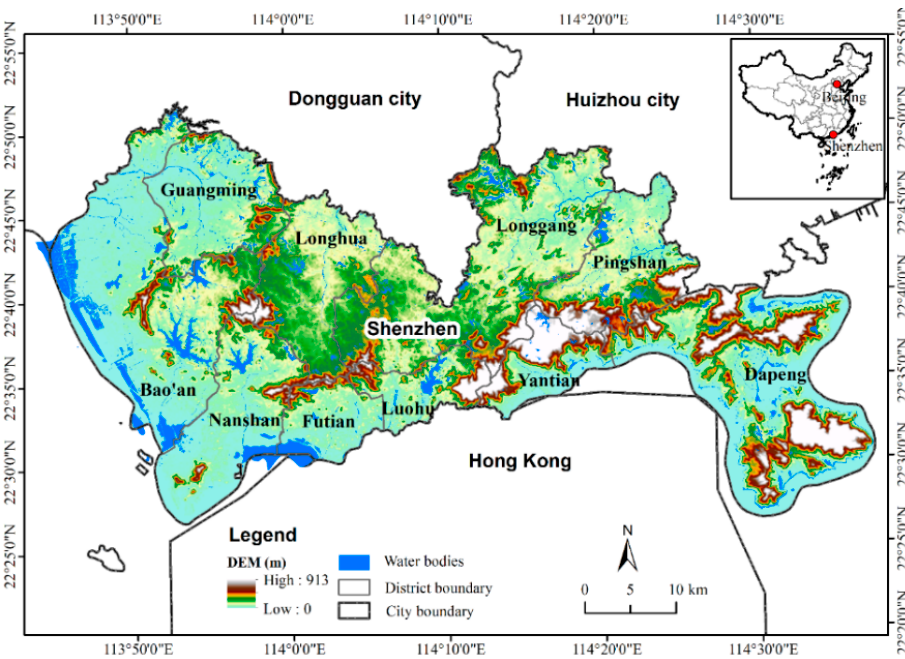
Figure 1. Location of Shenzhen City in China and its spatial extent.